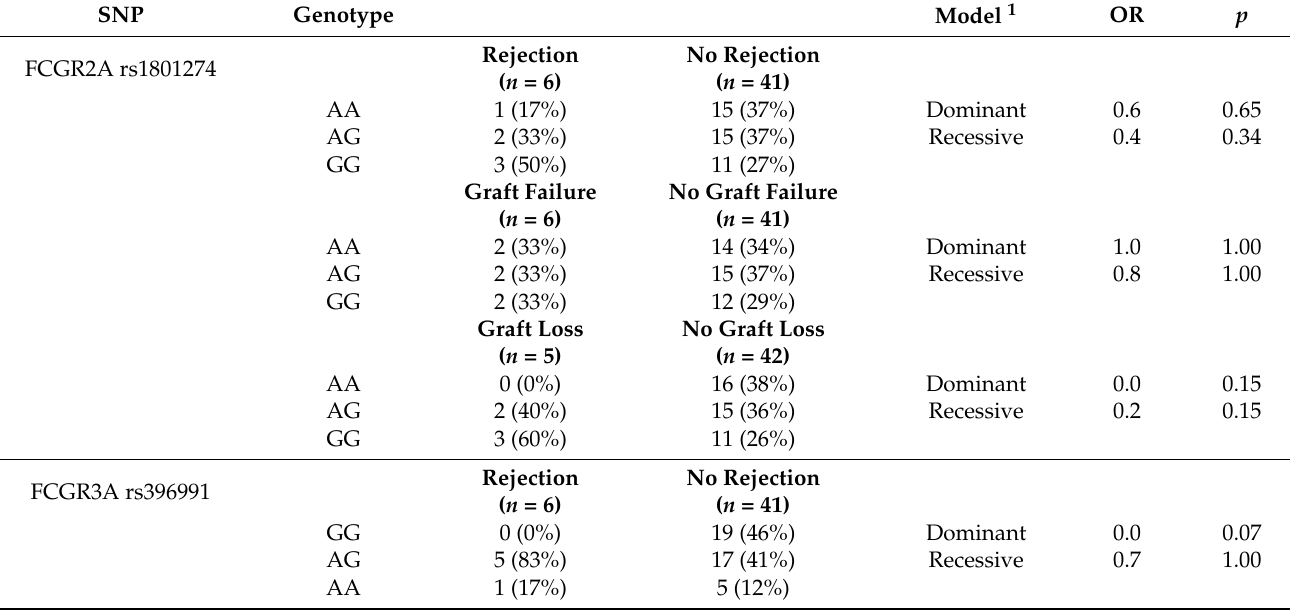
Table 2. Kidney allograft function, stratified by the FCGR2A and FCGR3A genotypes. SNP